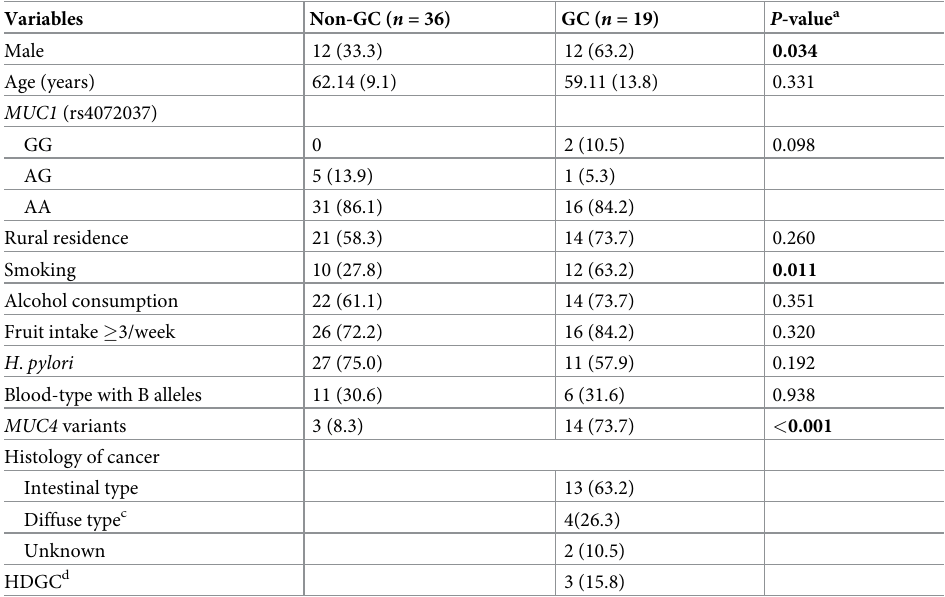
Table 1. Clinical and demographic characteristics of GC patients and non-GC